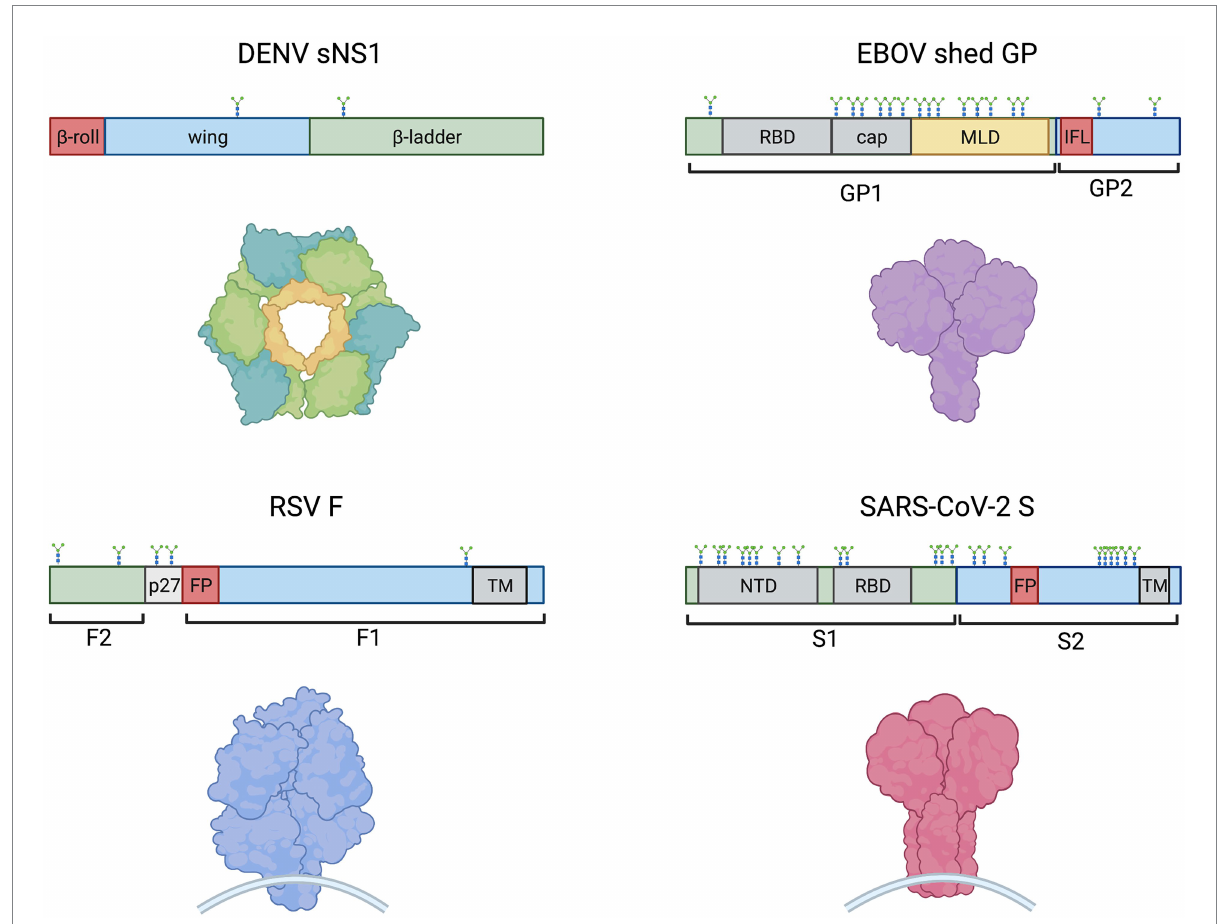
FIGURE 1 Schematic representations of monomeric DENV sNS1, EBOV shed GP, SARS-CoV-2 S and RSV F (clockwise) showing protein domain structure (above) and models of oligomeric proteins (below). Hydrophobic regions, such as the NS1 β -roll, the GP internal fusion loop (IFL) and fusion peptides (FP) are denoted in red. Other domains are indicated including receptor binding domains (RBD), glycan cap (cap), mucin-like domain (MLD), N-terminal domain (NTD), transmembrane domains (TM), and the RSV peptide 27 (p27). N-linked glycosylation sites are shown. The EBOV MLD shown in yellow also contains ~80 O-linked glycosylation sites (Cook and Lee,